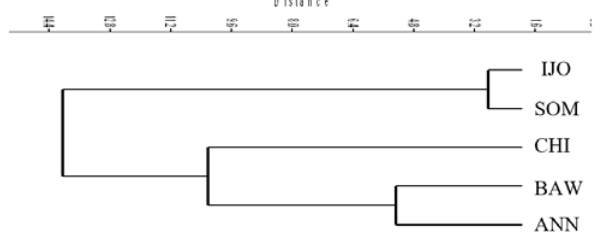
Mean quantitative fruit and seed morphological characters of the cultivars of